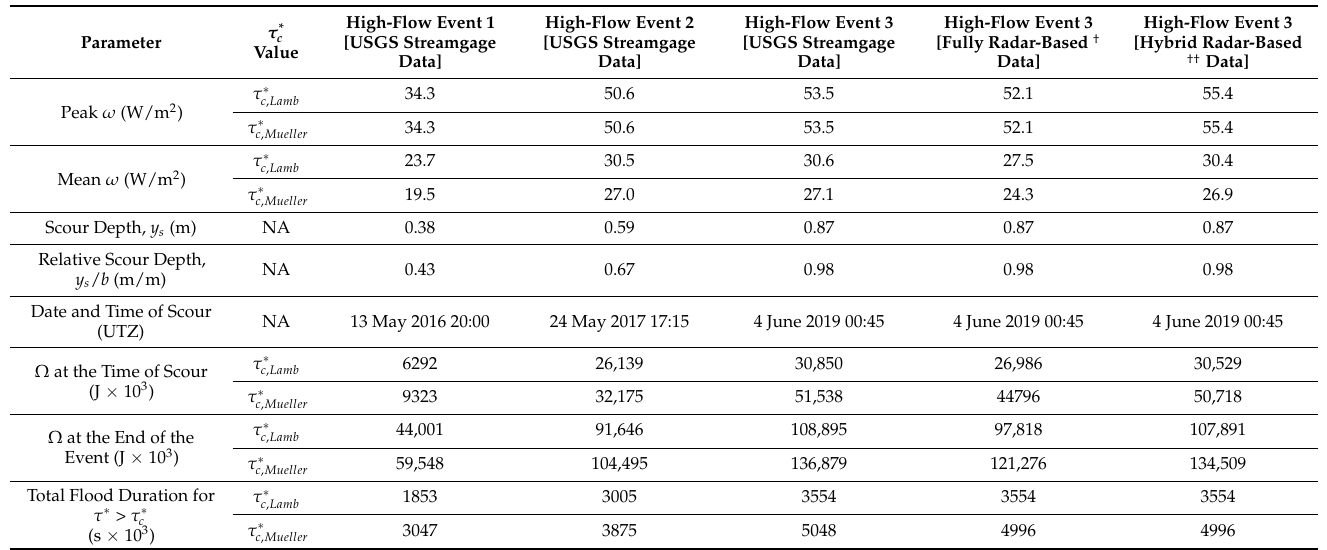
Table 5. Stream power and scour measurement results (including relative scour depth (scour depth [ y s ] normalized by pier width [ b ], or y s / b ) for each high-flow event, discharge estimation method, and τ ∗ c value. “NA” refers to data that are not applicable.